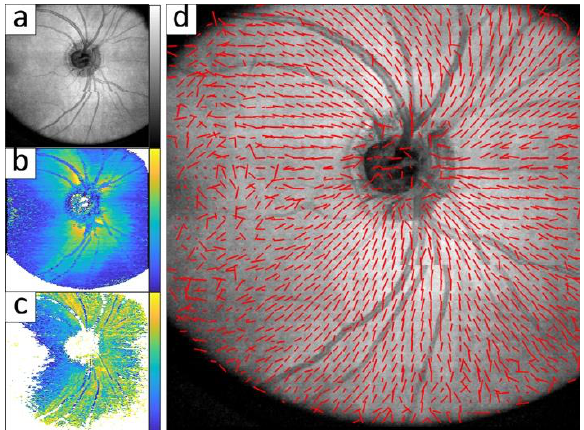
Fig. 1. PSOCT images of a healthy volunteer (a) Intensity en face image, (b) RNFL thickness image, (c) local birefringence image and (d) Intensity en face image overlaid with RNFL orientation as red lines. Color range in (b) indicates 0 – 300 μm. Color range in (c) indicates 0.5- 0.15 °/μm. Images s izes: 5.7 x 6.2 mm (depth x